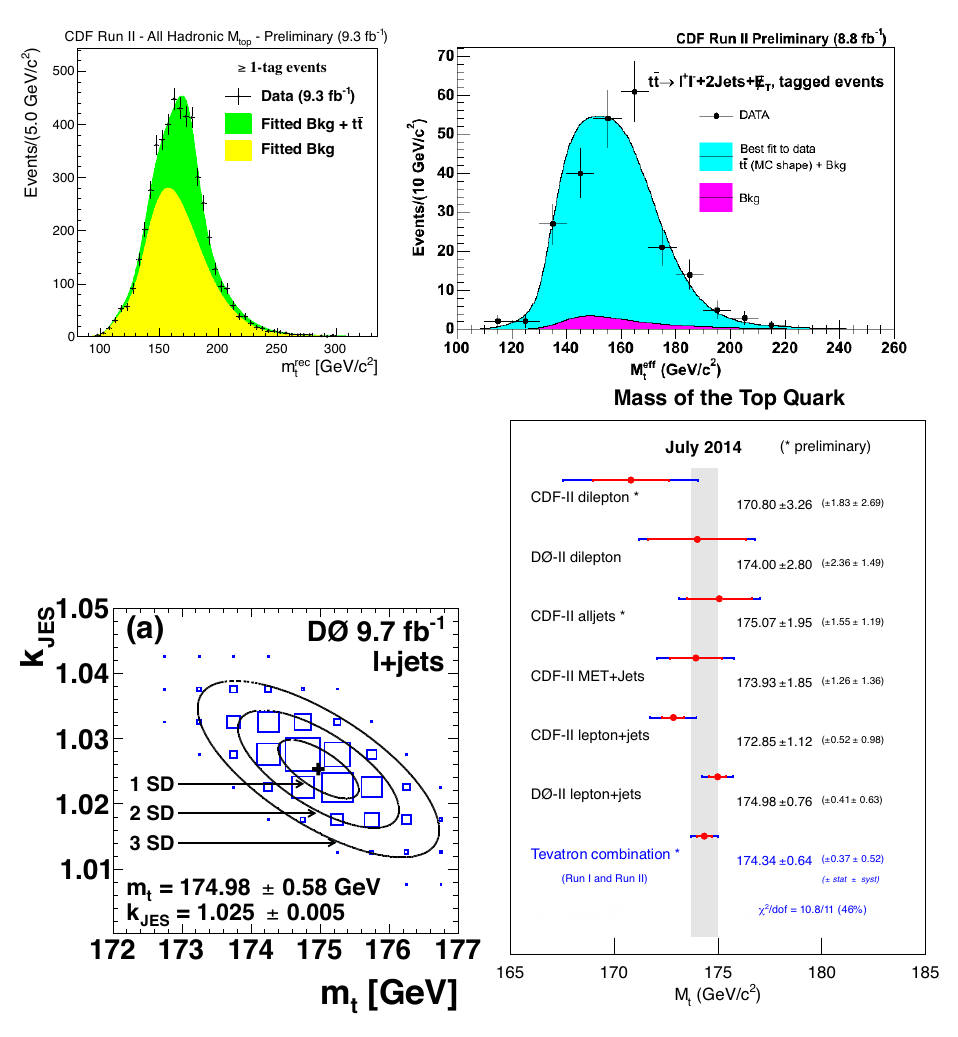
Figure 6. Top quark mass measurements at the